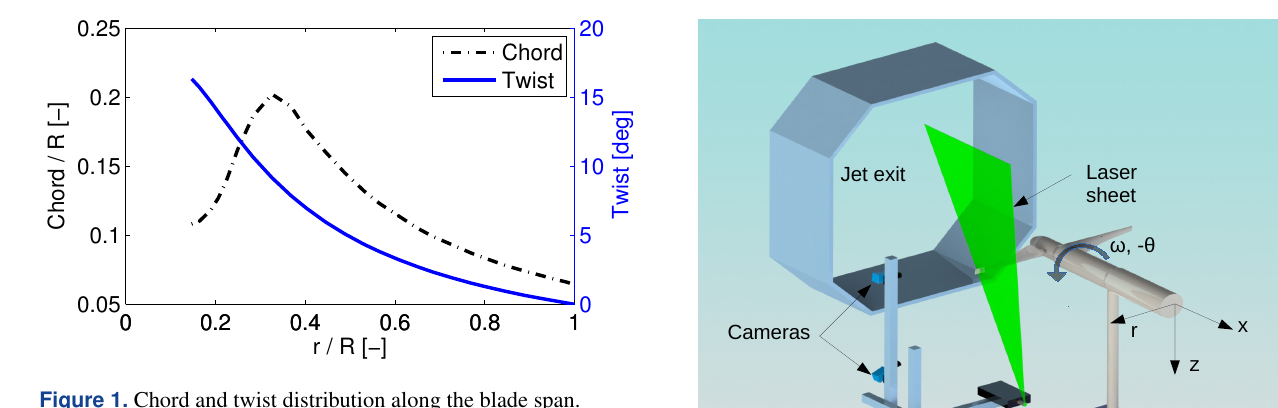
Figure 1. Chord and twist distribution along the blade span. Table 1. Airfoil type distribution along the blade span.